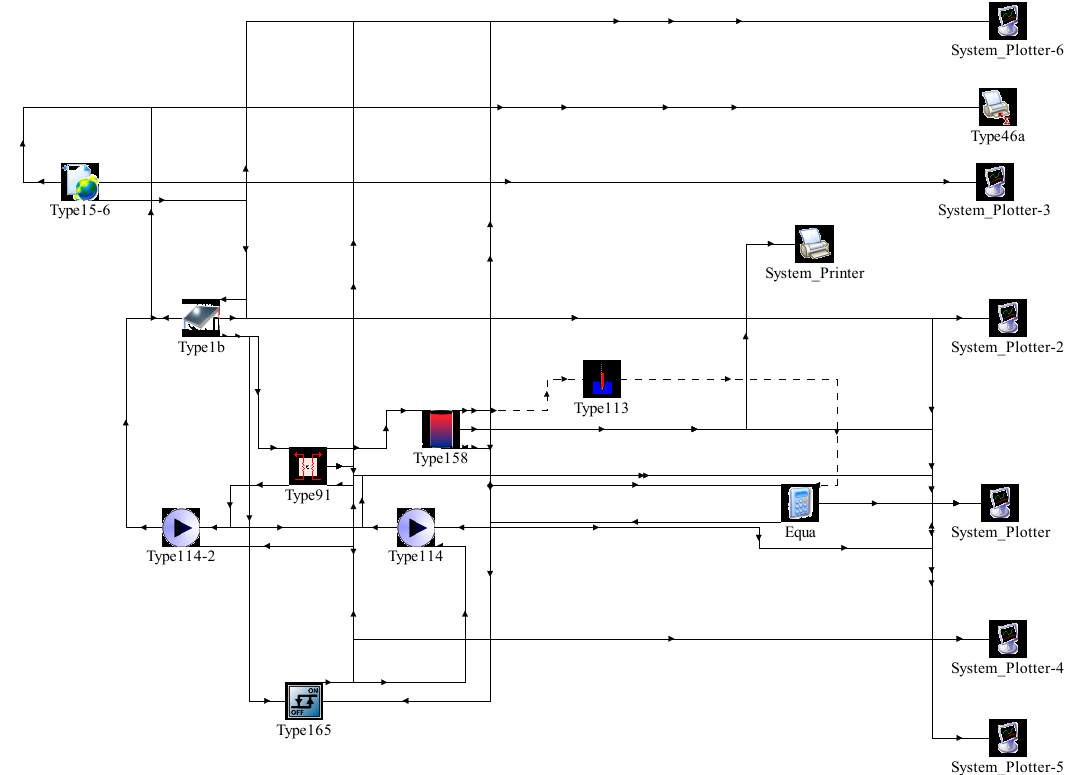
Figure 1. Scheme of the system model built in Transient System Simulation Tool (TRNSYS).